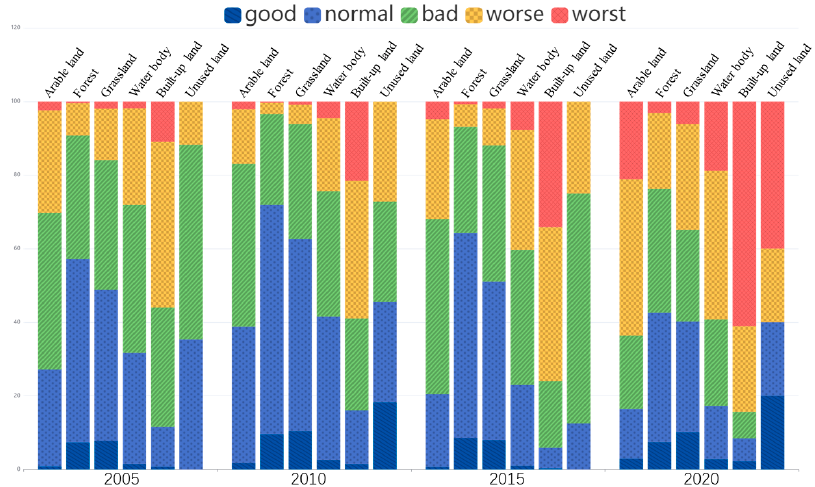
Figure 11. Proportion of UTCI of different LUCC types in GBA.